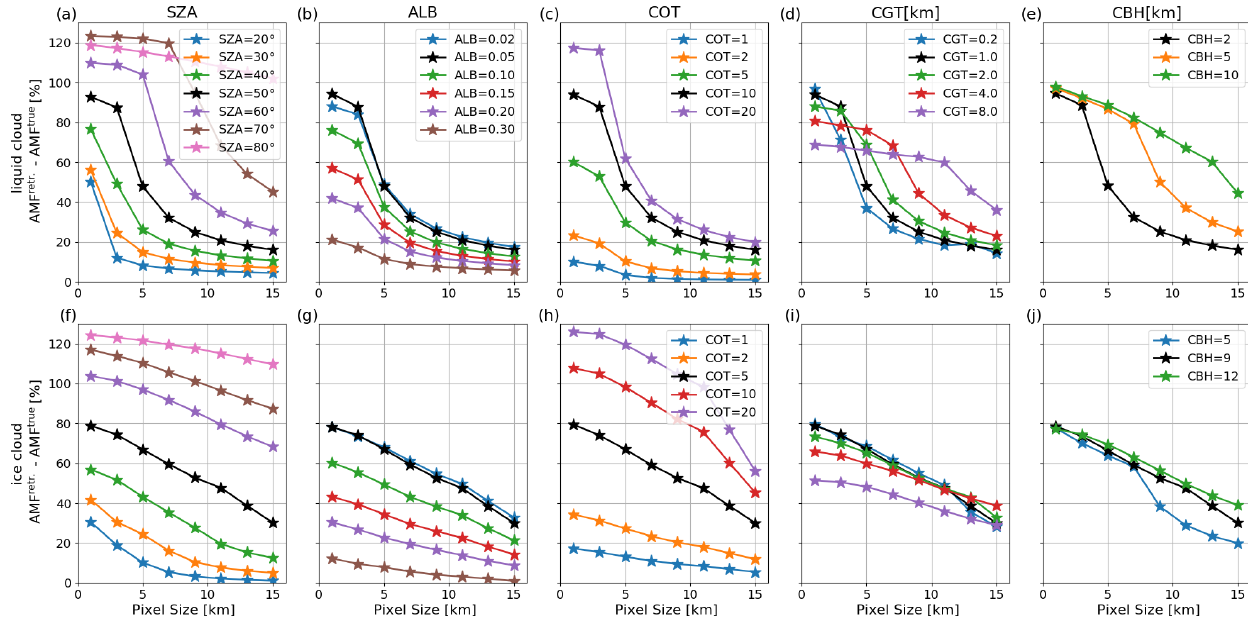
Figure 7. Maximum NO 2 AMF bias in the cloud shadow as a function of the pixel size for the liquid (2–3km altitude) and ice clouds (9–10km altitude) for various values of the SZA, ALB, COT, CGT, and